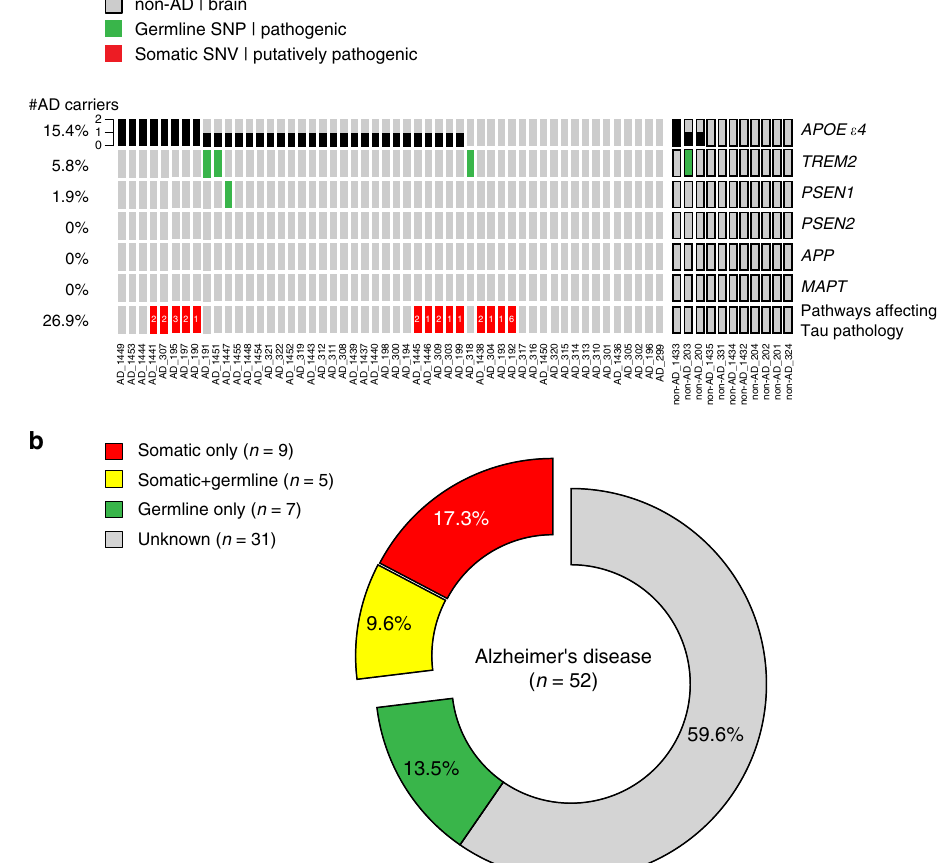
Fig. 4 Landscape of pathogenic germline and somatic mutations contributing to Alzheimer ’ s disease (AD). a The presence of pathogenic germline risk factors and putatively pathogenic somatic mutations across all AD and non-AD individuals. The copy number of APOE ɛ 4 alleles are annotated in black. Known risk modi fi ers of AD in APP , PSEN1 /2, TREM2 , and MAPT are marked in green. Putatively pathogenic brain somatic mutations associated with tau hyperphosphorylation-related pathways are marked in red, and the number of affected genes was annotated together. b Categorization of pathogenic germline and somatic mutation carriers among AD patients. 13.5% (7/52) of AD patients in our cohort could be explained by germline mutations alone; 26.9% (14/52) of AD patients harbored putatively pathogenic somatic mutation affecting the phosphorylation of